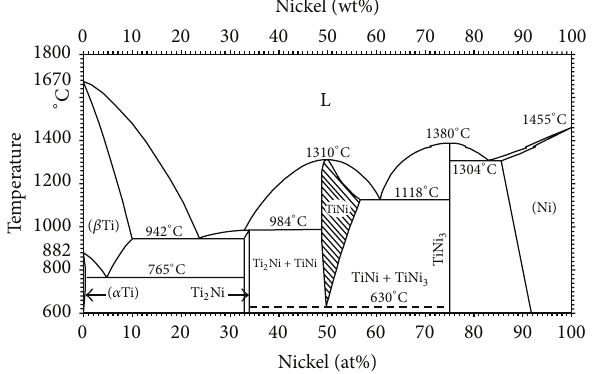
Figure 1: Equilibrium Ni-Ti phase diagram [20].